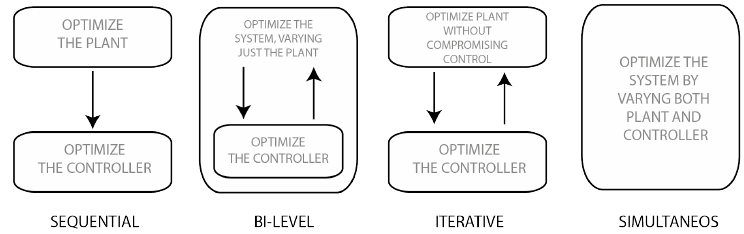
Figure 14. Strategies for plant/controller